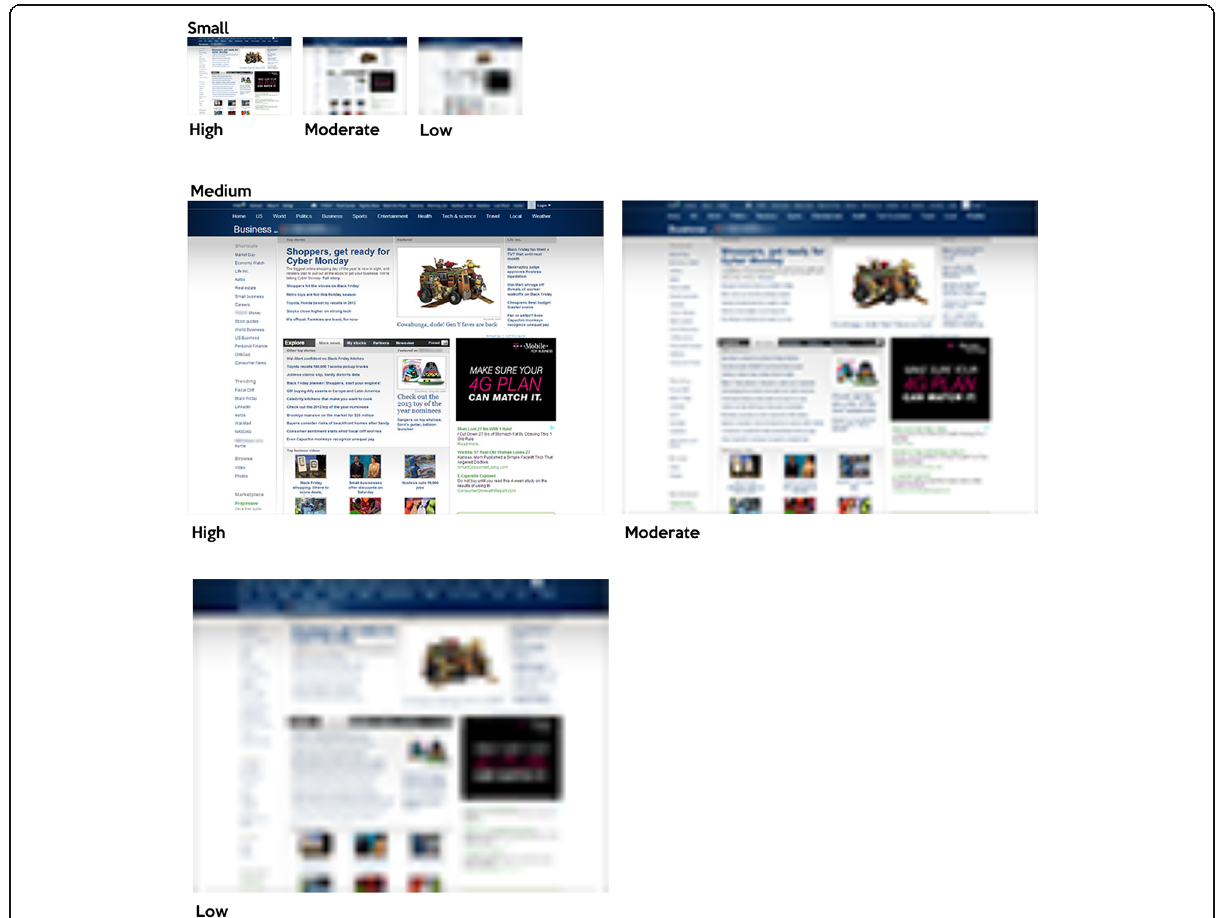
Fig. 8 Comparison of size and resolution of small and medium